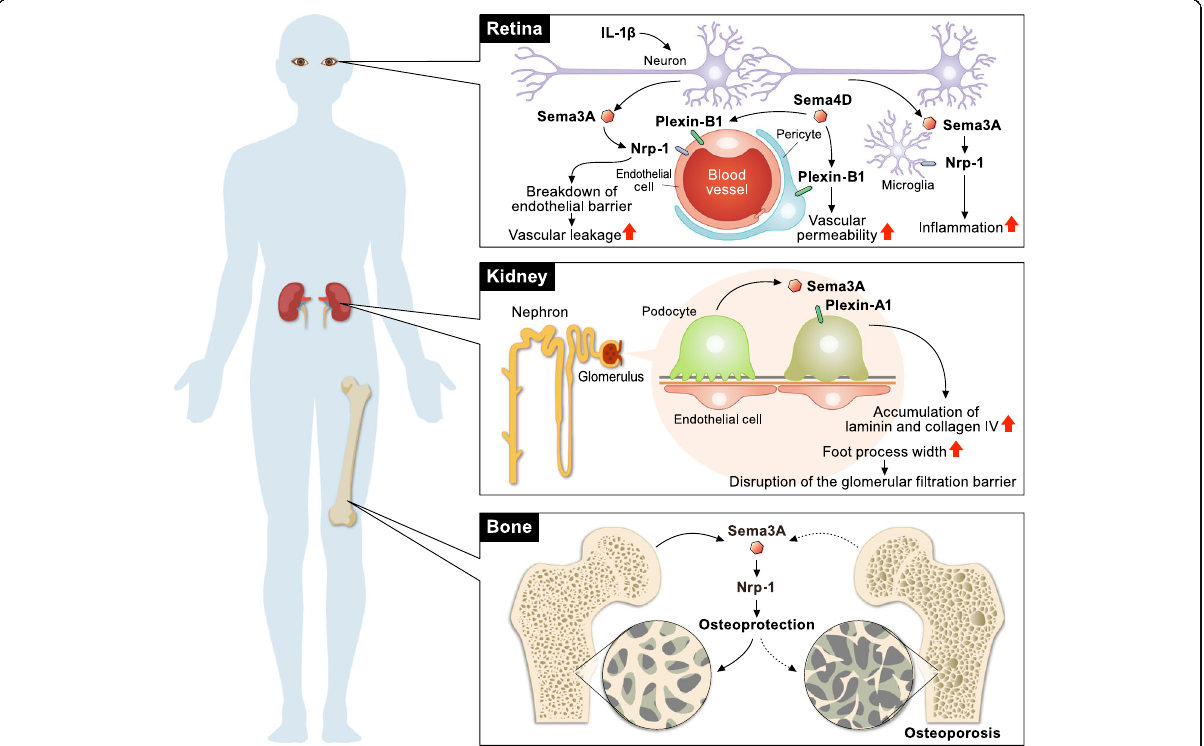
Fig. 2 Role of semaphorins in the development of diabetic complications. Sema3A exaggerates diabetic retinopathy via the breakdown of retinal endothelial cell barrier function and recruitment of proangiogenic microglia. In the kidney, Sema3A disrupts the glomerular filtration barrier, contributing to the development of diabetic nephropathy. In contrast, Sema3A exerts osteoprotective effects, leading to the suppression of diabetic